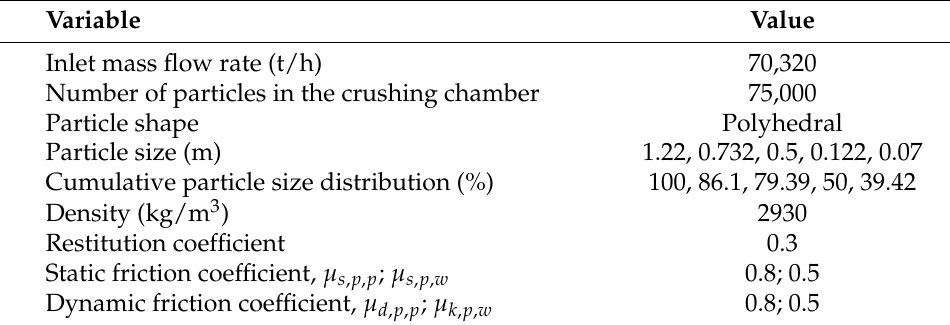
Figure 5. Particle shapes: ( a ) particle 1, ( b ) particle 2, ( c ) particle 3, and ( d ) particle 4. Figure 4. Particle shapes: ( a )particle 1, ( b )particle 2, ( c )particle 3, and ( d )particle 4. represent the product size distribution, the ratio of the minimum simulated size, k ms , is Table 2. Material parameters of the copper ore 331 defined as the minimum valid closed side setting divided by the minimum simulated 332